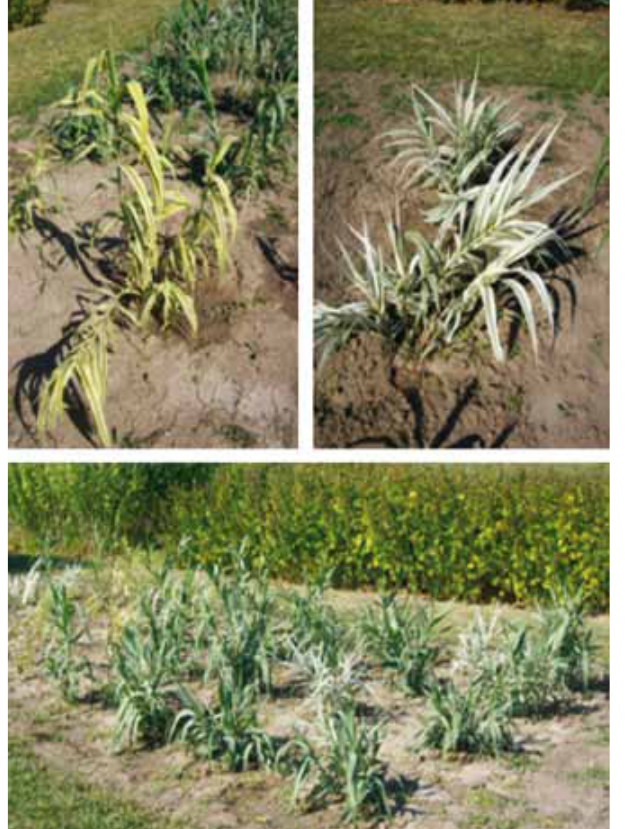
Figure 7: External morphological description of the new ornament macrophyla and longicaulis Italian cane ecotypes and their